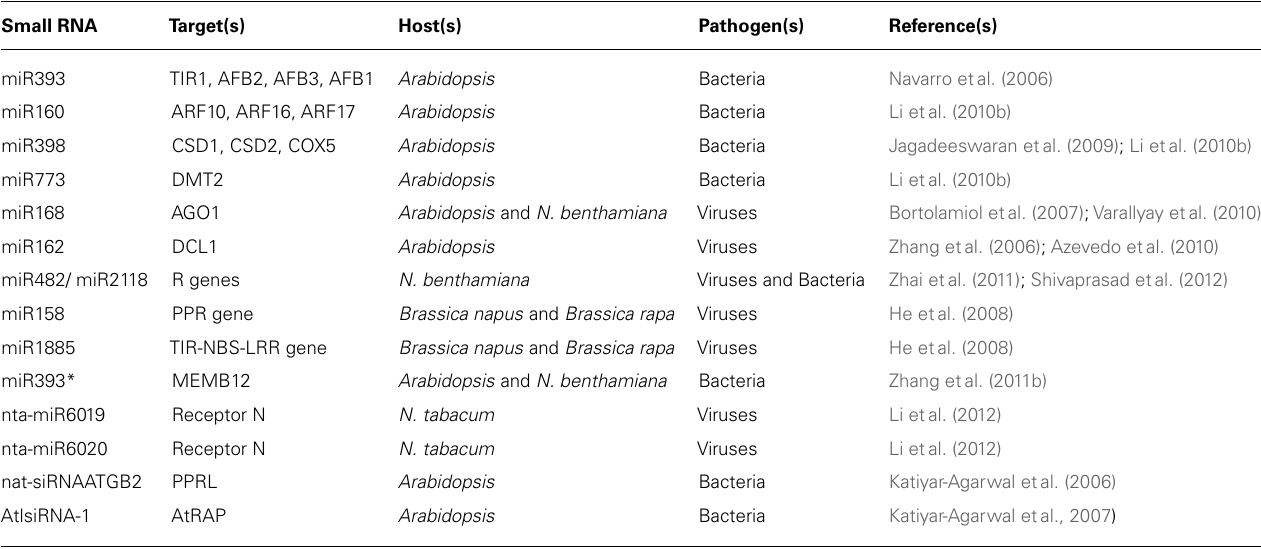
Table 1 | Plant small RNAs involved in plant